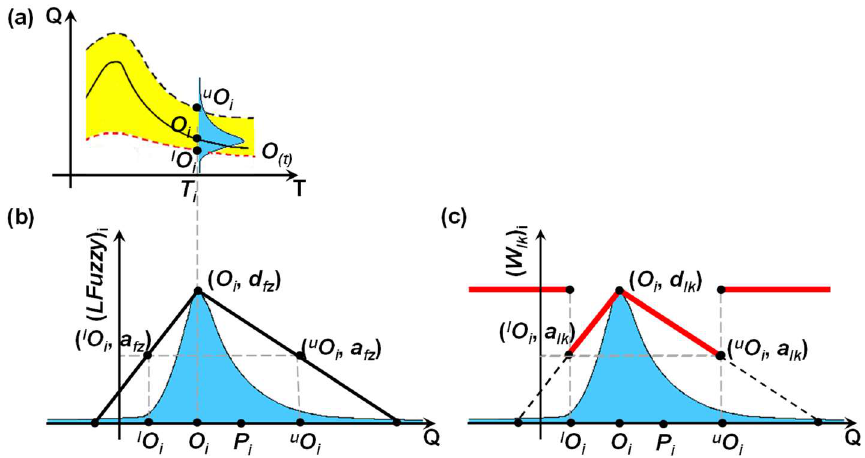
Figure 3. Schematic description of the linear approach that was used for defining ( a , b ) the linear fuzzy (likelihood) measure ( LFuzzy ) and ( c ) the residual reduction fraction ( w lk ).